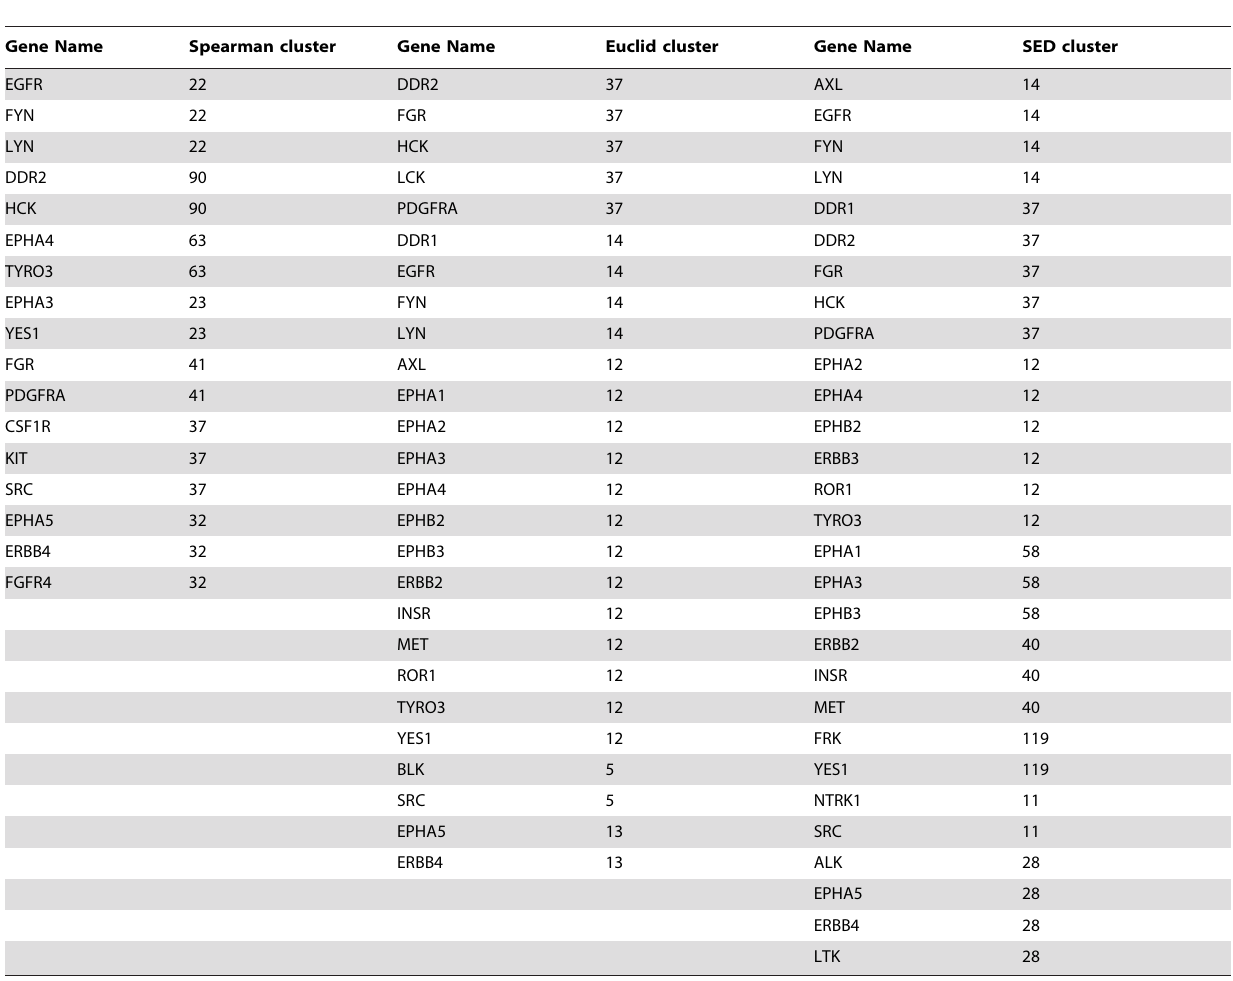
Table 3. Tyrosine kinases in